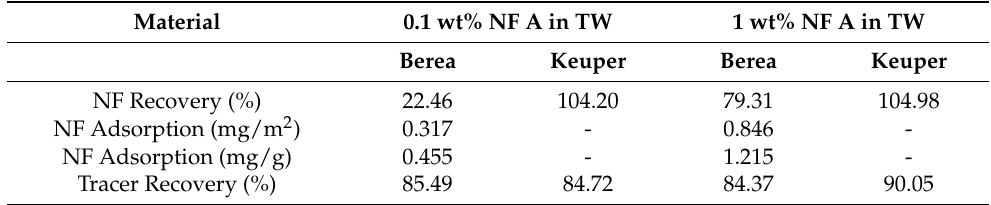
Table 7. Adsorption results following mass balance calculation for NF A in Berea and Keuper.